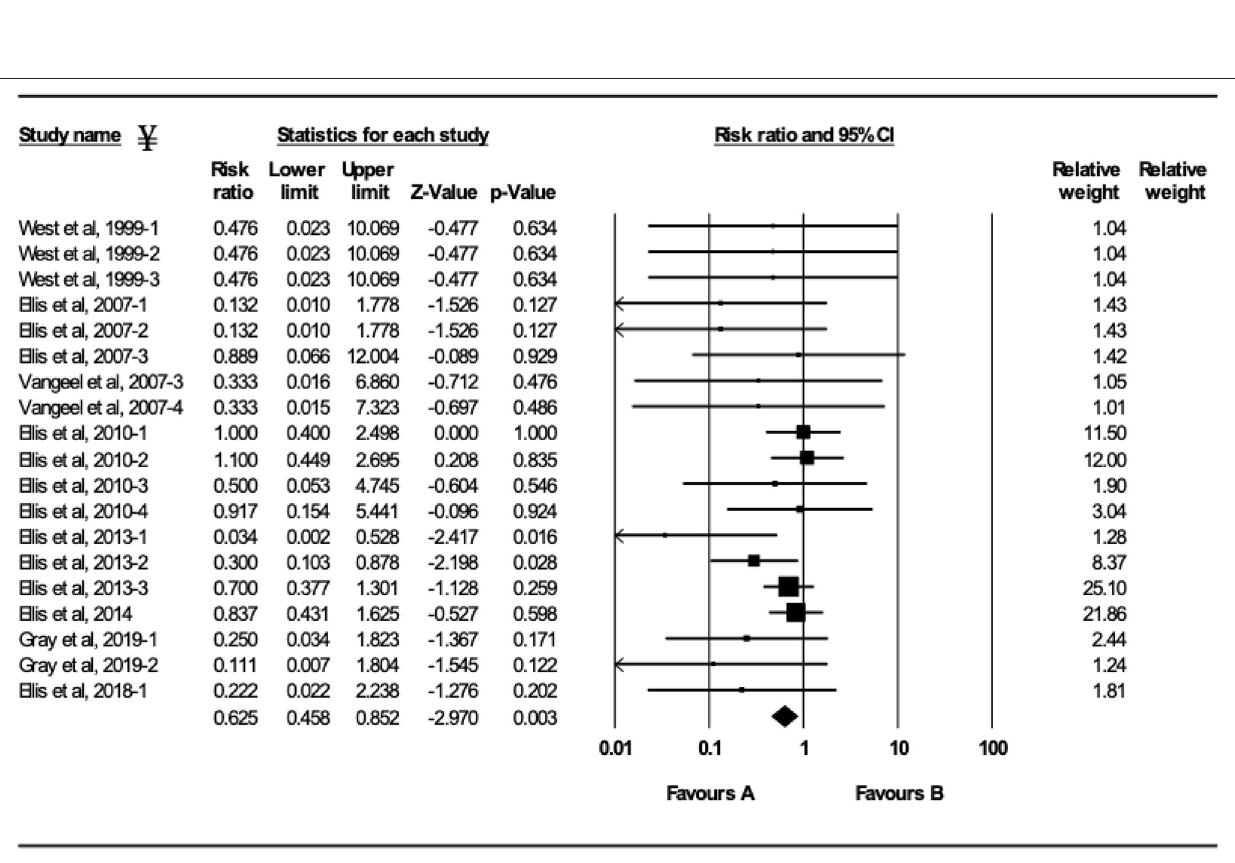
Frontiers in Veterinary Science |